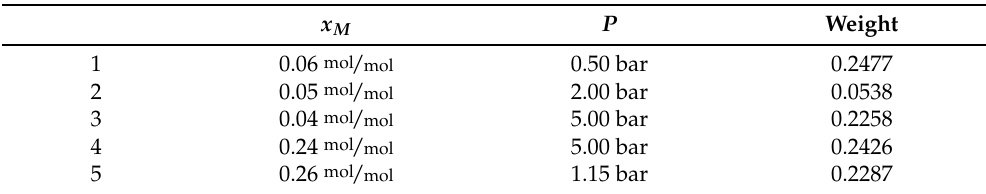
Table 1. Optimal design ξ VDM computed with the vertex direction method (VDM) for the flash with a methanol-water input feed.